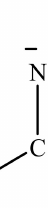
Figure 3. Condensation reaction yielding the pyrimidine